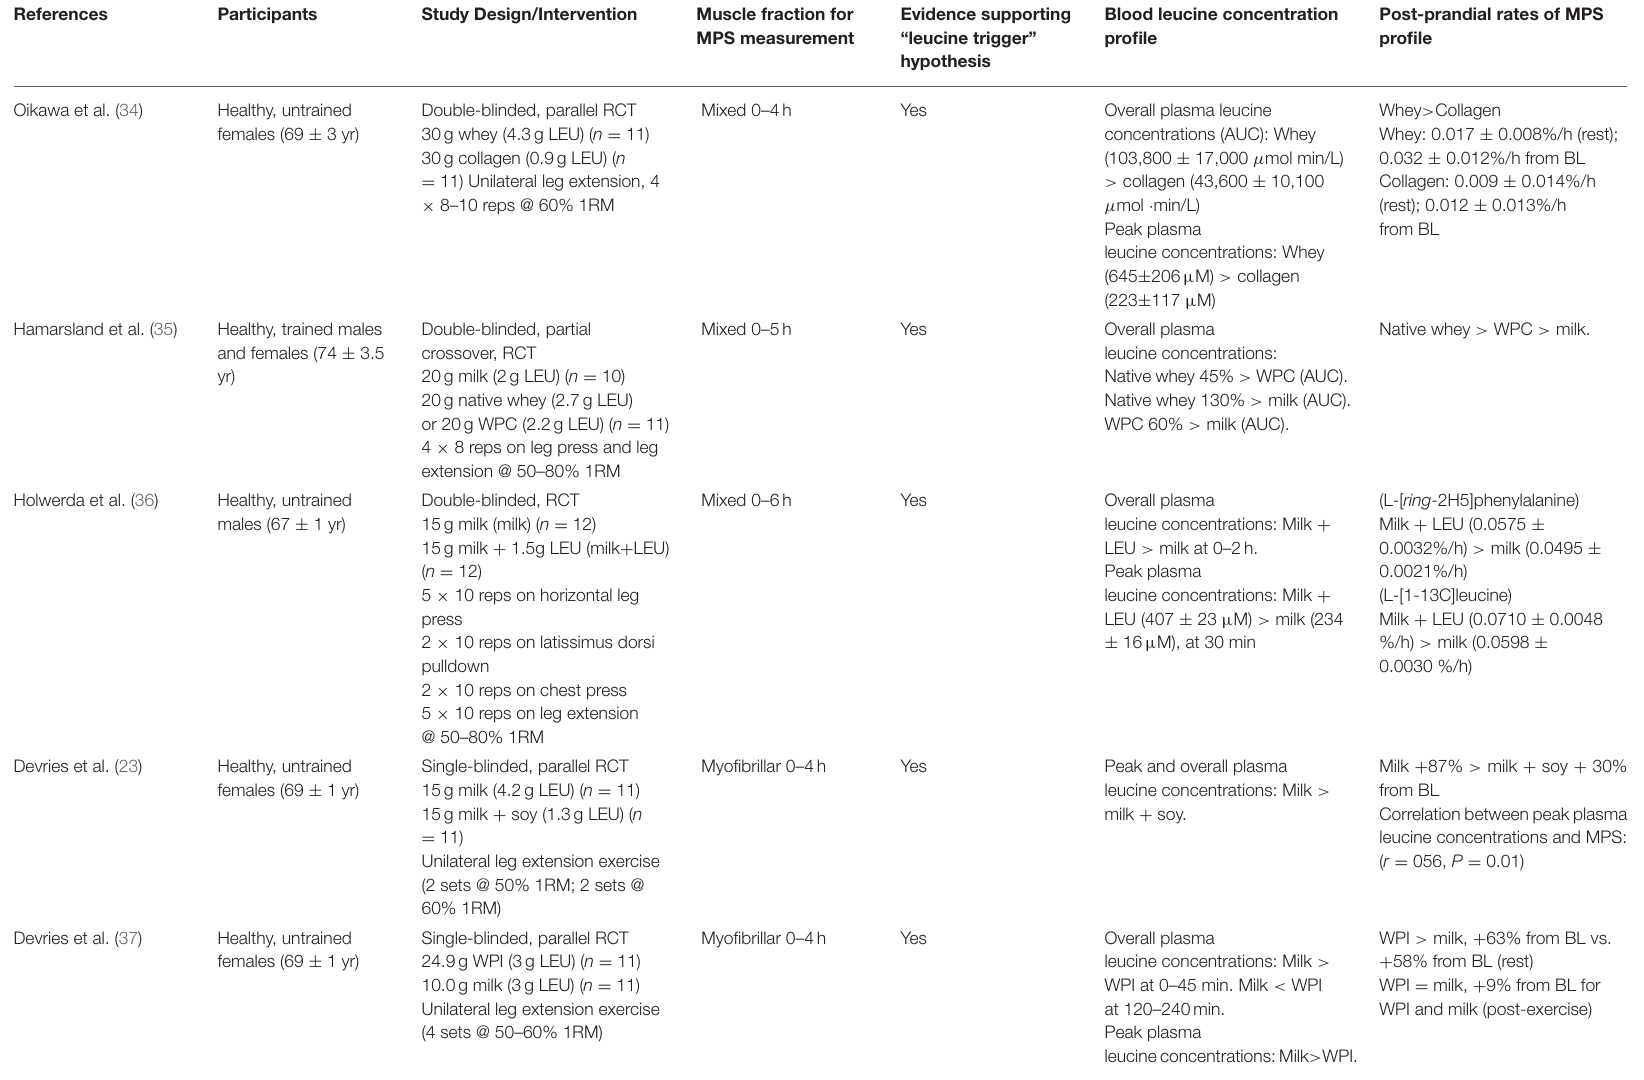
TABLE 3 | Summary of findings from studies that measured blood leucine concentration profiles and post-prandial rates of muscle protein synthesis following exercise in older